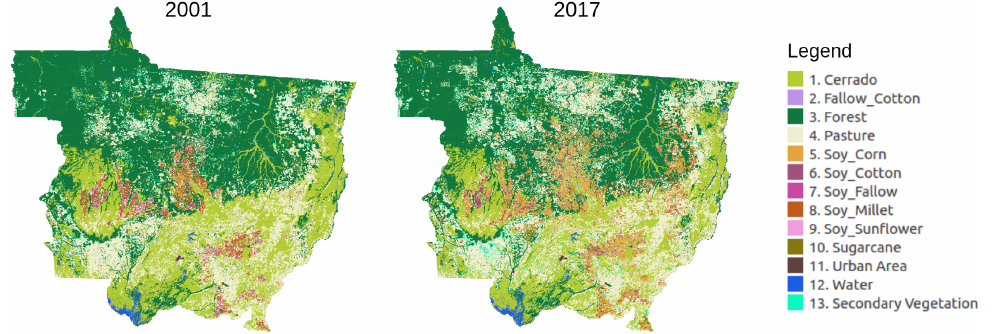
Figure 2. Land use and land cover maps for the Mato Grosso State in 2001 and 2017. Source: Câmara et al.